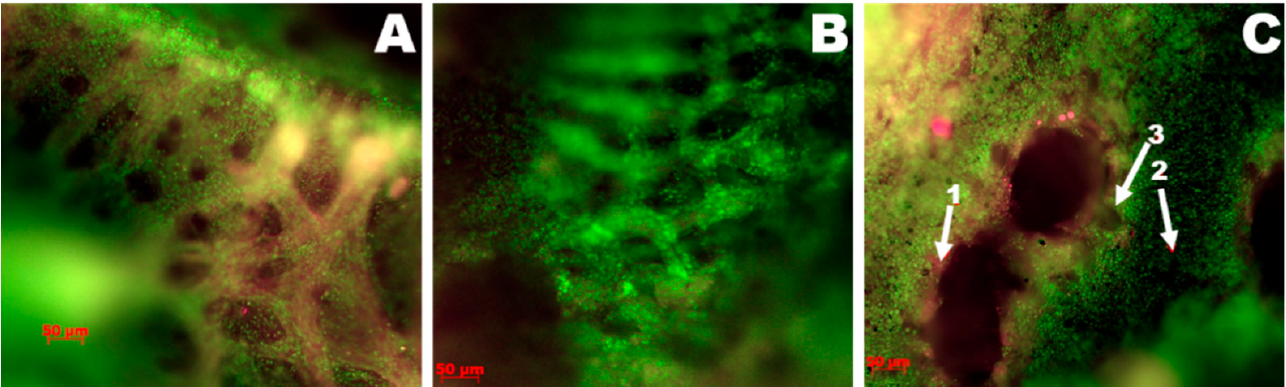
Figure 3. Luminescence microscopy photograph of lung preparations of the group treated with Argovit, stained with SYBR Green and Sypro Ruby ( × 50). ( A , B ) No inflammatory changes were observed. ( C ) The bronchus lumen: 1—the parabronchus wall, 2—the air capillary mouth, 3—the lung parenchyma in a state of vascular hyperemia.